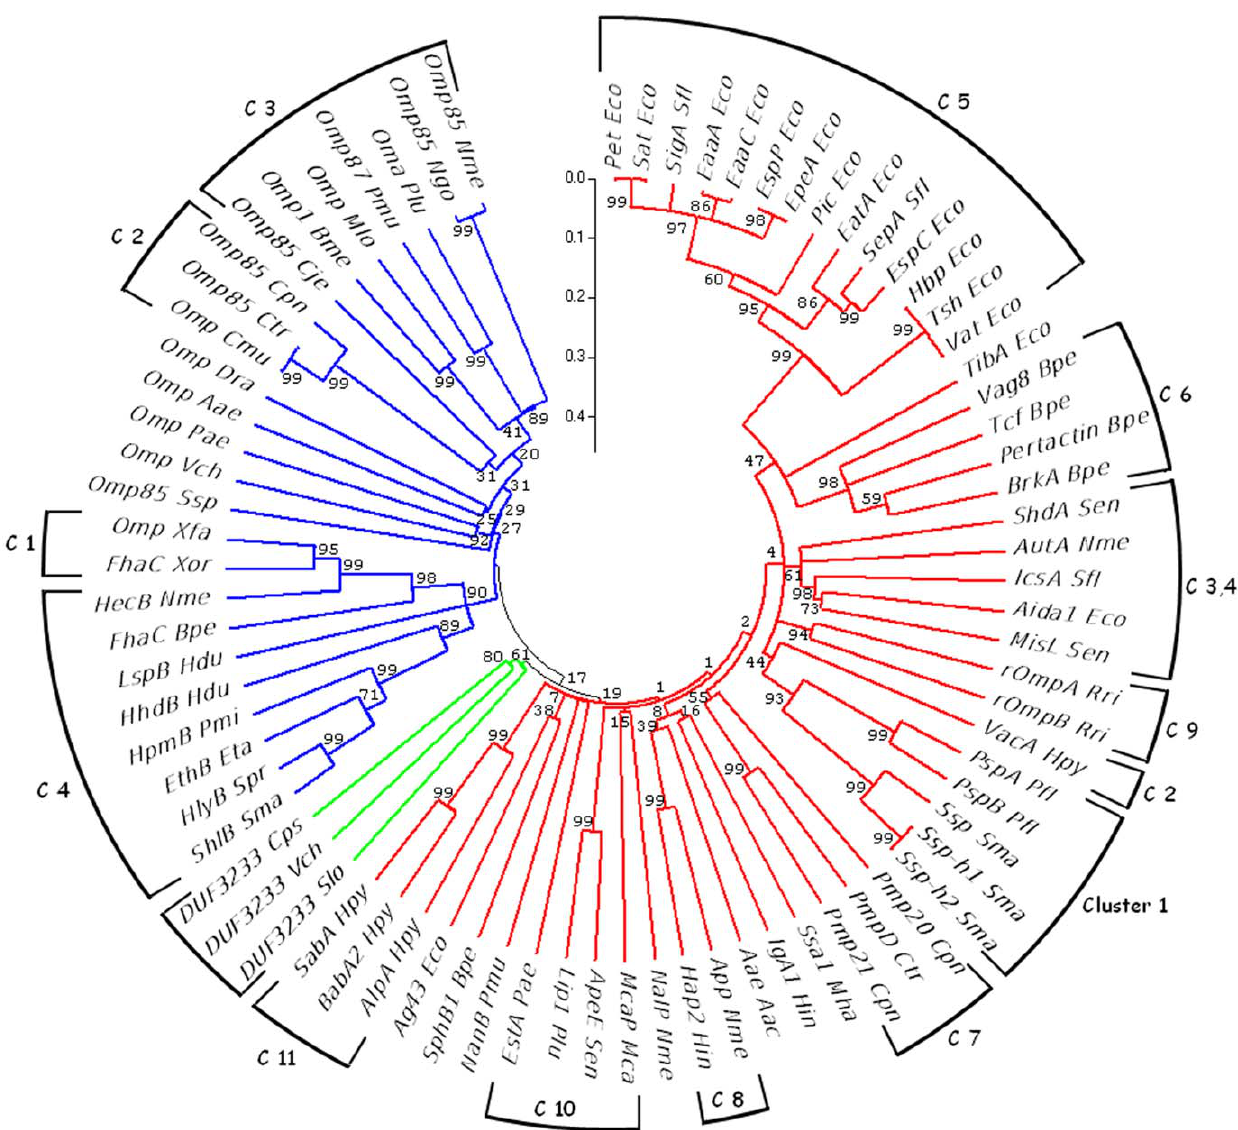
Figure 4. Bootstrap phylogenetic tree of DUF3233 with Va and Vb family proteins. 51 Va family (red), 25 Vb family (blue) translocation unit and 3 DUF3233 (green) representative sequences were used to generate a 1000 replicate bootstrap phylogenetic tree. Eukaryotic Vb sequences representing clusters 1 and 2 were not considered in the analysis. Sequences of each family are grouped into previously reported clusters (C 1 to 11 and C 1 to 4); DUF3233 sequences form a new cluster of the autotransporter family. Numbers at the node indicate neighbour-joining bootstrap percentages. Phylogenetic analyses were conducted in MEGA4.